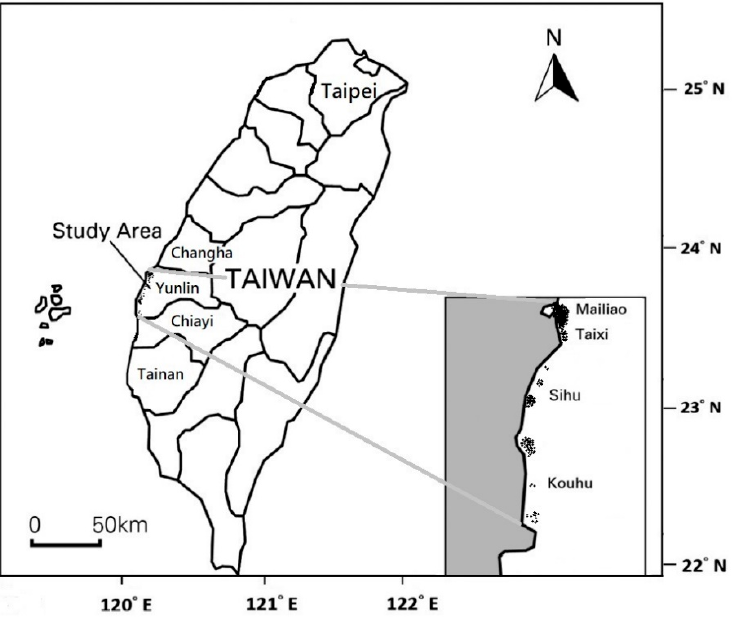
Figure 1. Geographical locations of the hard clam farms in Yunlin County, Taiwan .